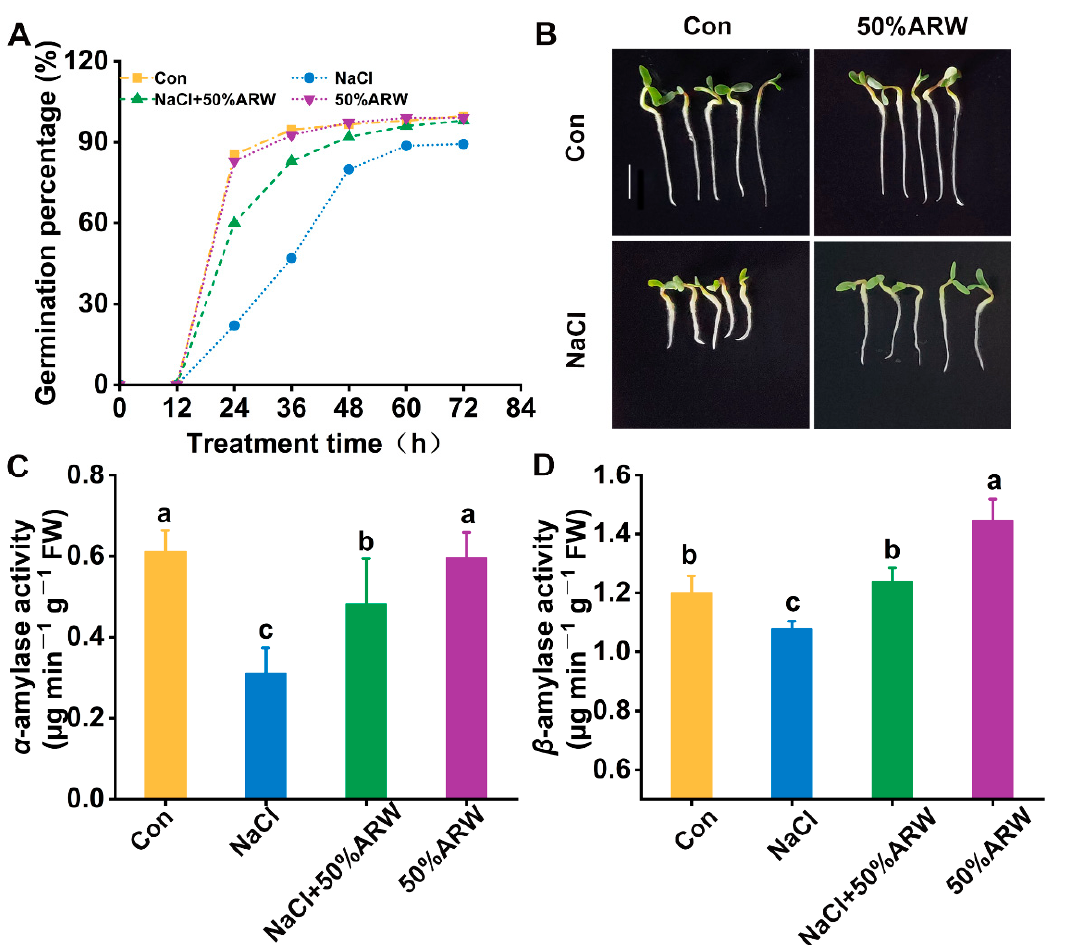
Figure 1. The inhibition of seed germination and reduction in amylase activity caused by NaCl stress were alleviated by argon. Alfalfa seeds were incubated in 0 (Con) or 50% argon − rich water (ARW) with or without 100 mM NaCl. Germination percentage was recorded at the indicated time points ( A ). After treatments for 72 h, phenotypic photos were taken ( B ). Bar = 1 cm. The activities of α -amylase ( C ) and β -amylase ( D ) were also detected. The error bars represent the SD ( n = 3; 100 samples/treatment/repeat for A). Bars with different letters (a–c) were significantly different at p < 0.05 according to Duncan’s multiple range test.